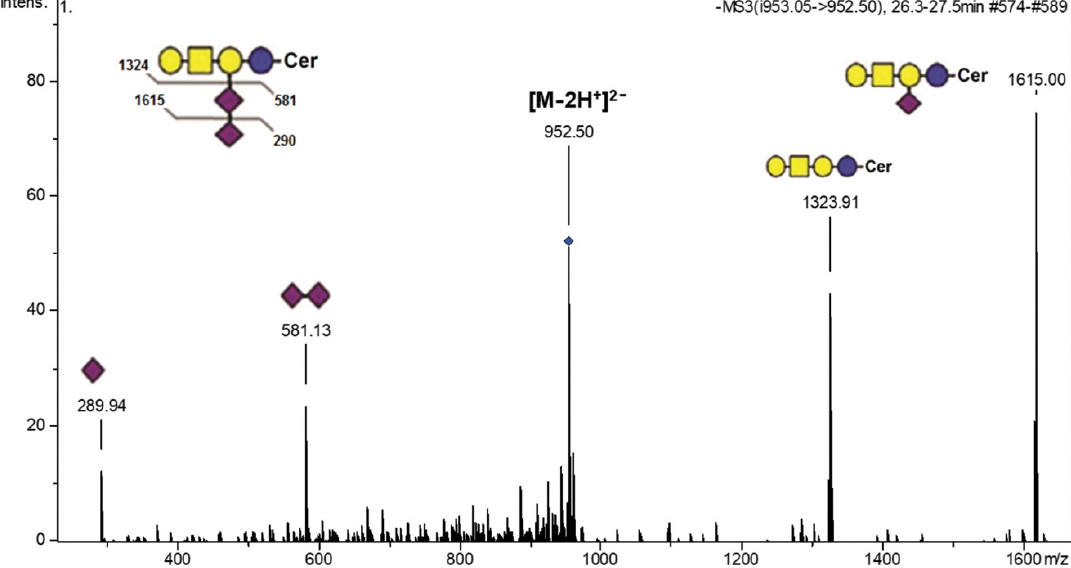
Figure 5. Fragmentation spectra obtained via CID MS 2 of the [M-2H + ] 2 − ion at m/z 952.50 confirming the GD1b (d18:1/23:0) structure in the ganglioside mixture from anaplastic ganglioglioma tumor tissue.